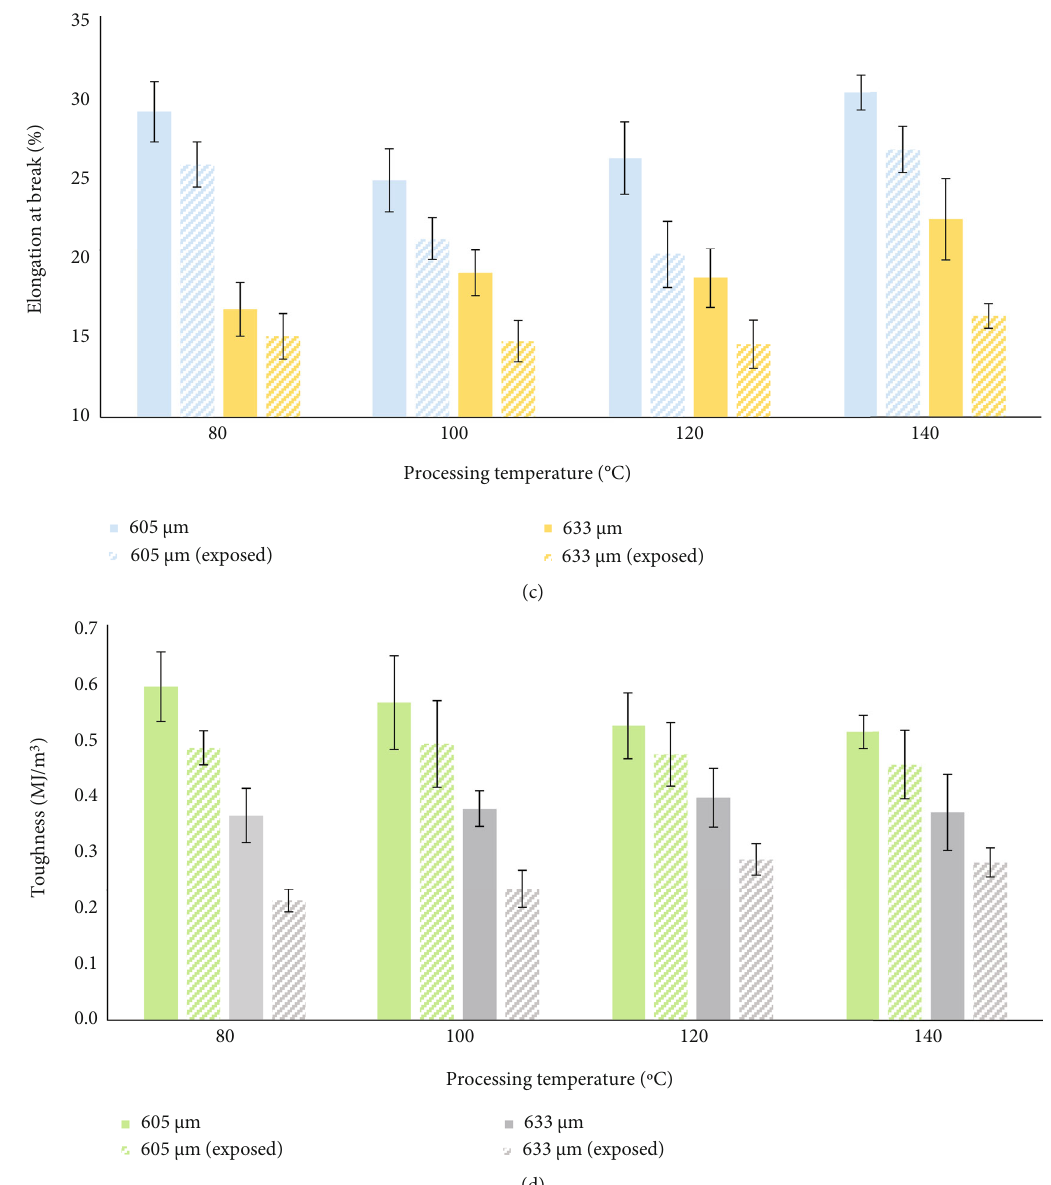
Figure 6: Tensile characteristics of OPEFB/acrylic thermoplastic composites: (a) tensile modulus, (b) tensile strength (c) elongation at break, and (d)